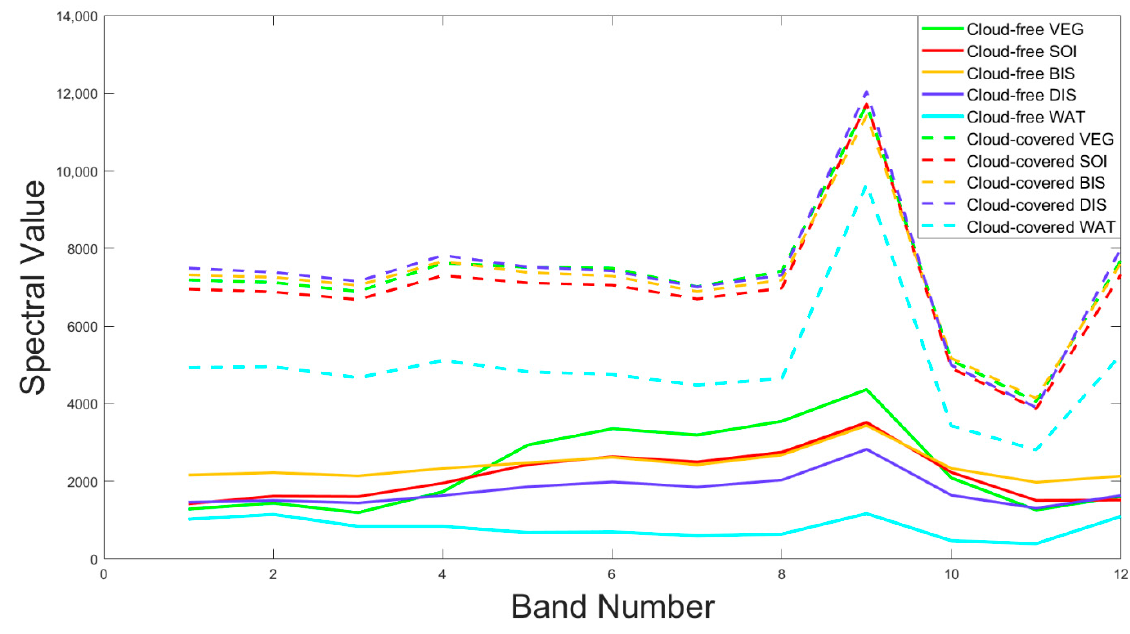
Figure 6. The spectral values of the five cloud-free and cloud-covered land cover samples in 12 bands.